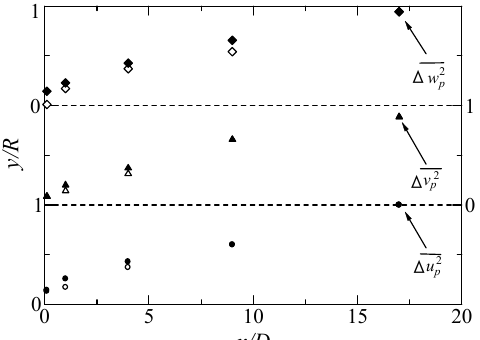
Fig. 6 The maximum difference of mean square velocities of disturbed and undisturbed flows (for symbols, open; d-type, L / D = 15 and closed filled; k-type, L / D =